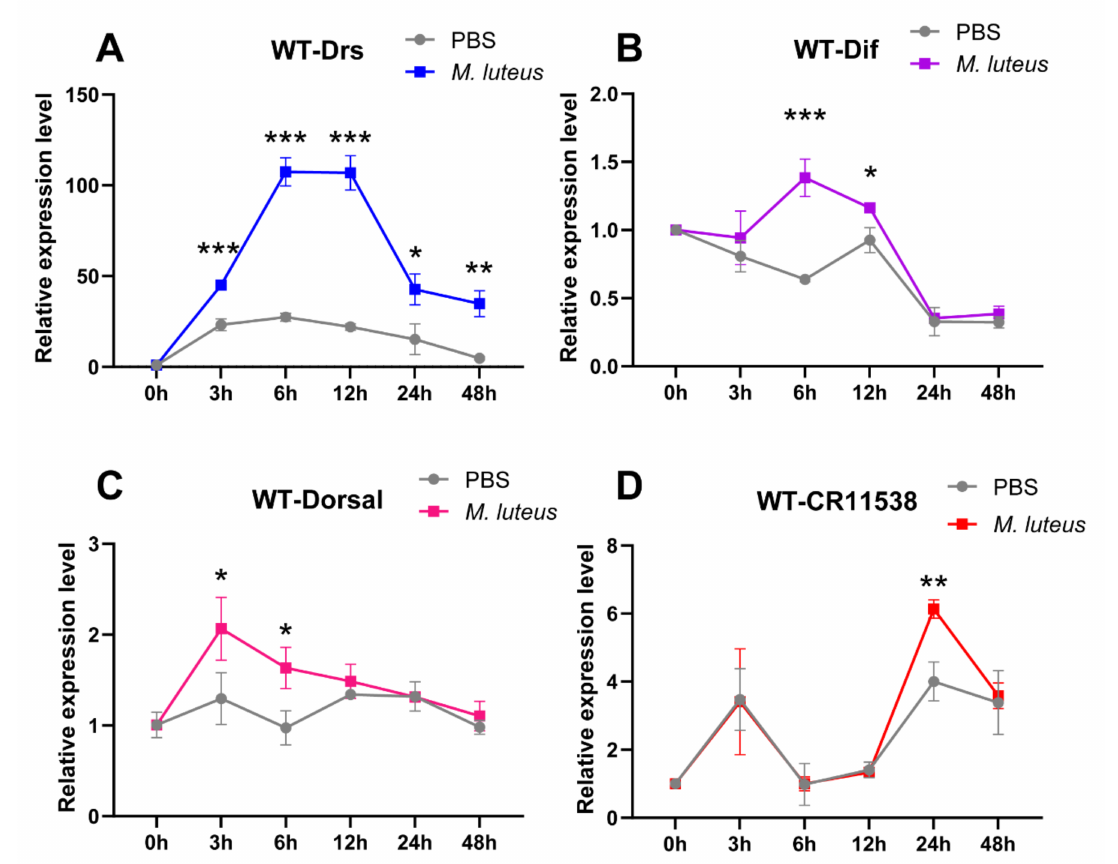
Figure 6. LncRNA-CR11538 facilitates immune homeostasis recovery. The dynamic expression levels of Drs ( A ), Dif ( B ), Dorsal ( C ), lncRNA-CR11538 ( D ) in the wild-type Drosophila infected with M. luteus were detected by qRT-PCR at 0 h, 3 h, 6 h, 12 h, 24 h and 48 h after stimulation. For all tests, p value < 0.05 was considered as statistically significant. * p < 0.05; ** p < 0.01 and *** p < 0.001 vs. the control